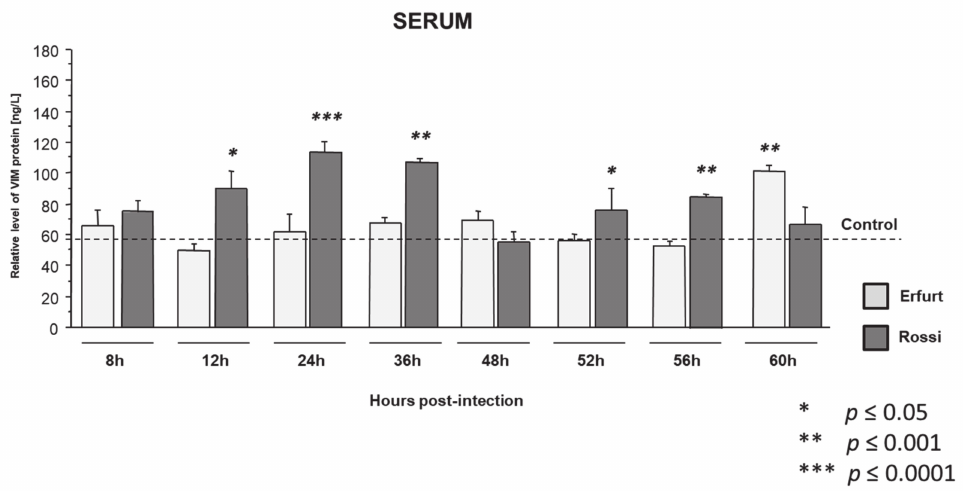
Figure 2. Protein expression of vimentin in the serum during RHDV infection. The boxes indicate the protein level of vimentin of the rabbits infected with the two strains of RHDV (Erfurt and Rossi) in comparison to the healthy controls. Data are shown as the mean ± standard error, and p < 0.05 was considered